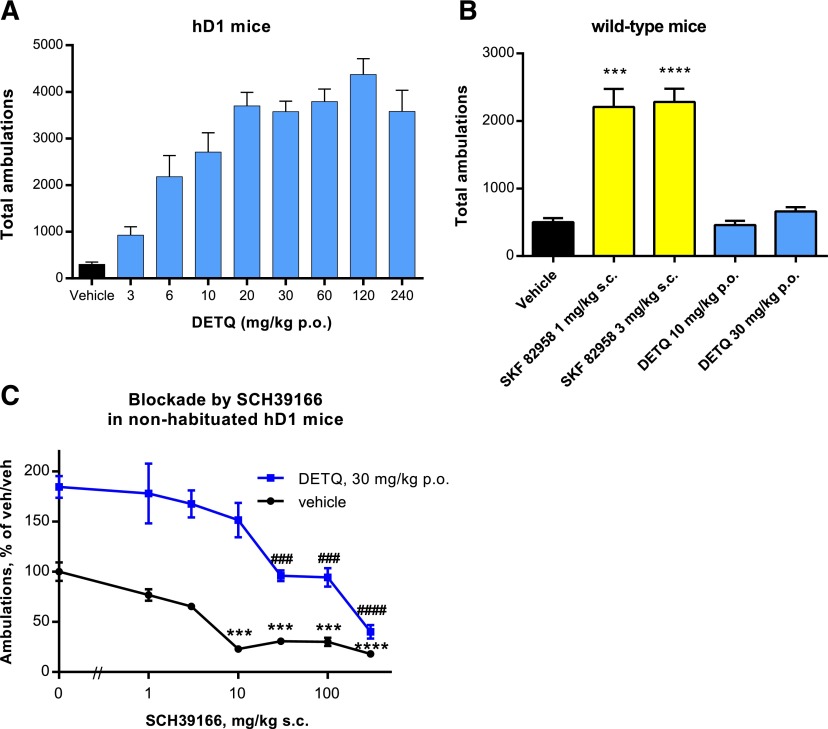
Locomotor response to DETQ in habituated hD1 and wild-type mice. LMA responses in (A) hD1 mice and (B) wild-type C57Bl/6 mice after oral dosing. The values in A are mean ± S.E., n = 7 to 16. All values for DETQ-treated animals in A are significantly different from vehicle (Dunnett’s multiple comparison test on log-transformed data, P < 0.0001). The values in B are mean ± S.E., n = 32 for vehicle and each DETQ dose, and n = 8 for each SKF 82958 dose. Groups were compared with vehicle by two-sided t test: ***P < 0.001, ****P < 0.0001. (C) Blockade by the D1-selective antagonist SCH39166 of the LMA response to DETQ in nonhabituated hD1 mice. Mice were pretreated for 30 minutes with either vehicle or SCH39166, after which they were treated with either vehicle or DETQ. The LMA was summed over a 1-hour period. The values shown are mean ± S.E., n = 20 for vehicle/vehicle, n = 15 for vehicle/DETQ, n = 5 for all other experimental conditions. The effect of SCH was analyzed by Dunnett’s multiple comparisons test: ***P < 0.001, ****P < 0.0001 for SCH/vehicle versus vehicle/vehicle; ###P < 0.001, ####P < 0.0001 for SCH/DETQ versus vehicle/DETQ. Additionally, all comparisons between SCH/vehicle and the same dose of SCH with DETQ were statistically significant at the P < 0.05 level or better (two-sided t test with Welch’s correction for unequal variances).